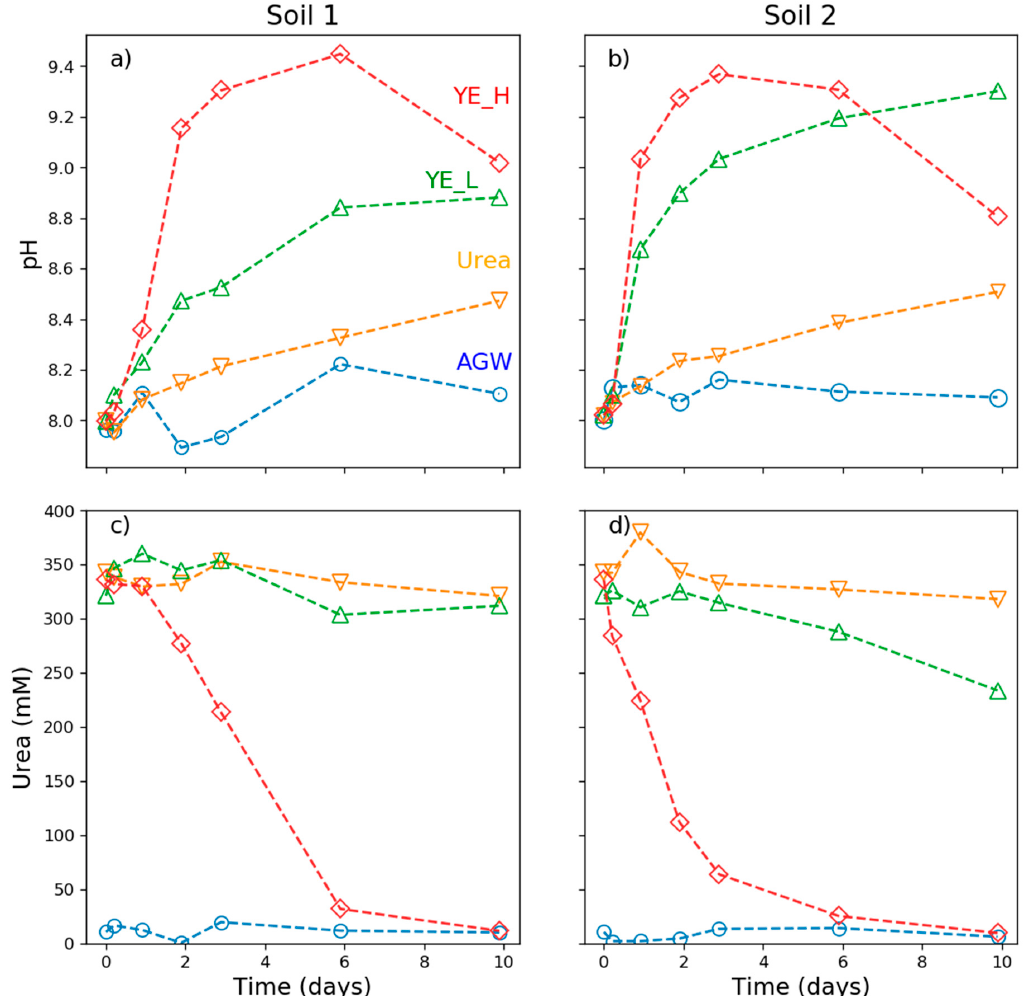
Figure 3. Biostimulation of soils from the stimulated soils from the Rotem Plateau. ( a ) pH of soil 1; ( b ) pH of soil 2; ( c ) urea concentration of soil 1 and ( d ) urea concentration of soil 2. AGW is artificial ground water (o); urea is urea control ( ∇ ); YE_L is low (0.1 g / L) yeast extract enriched medium ( ∆ ); YE_H is high (1.0 g / L) yeast extract enriched medium ( ♦ ).